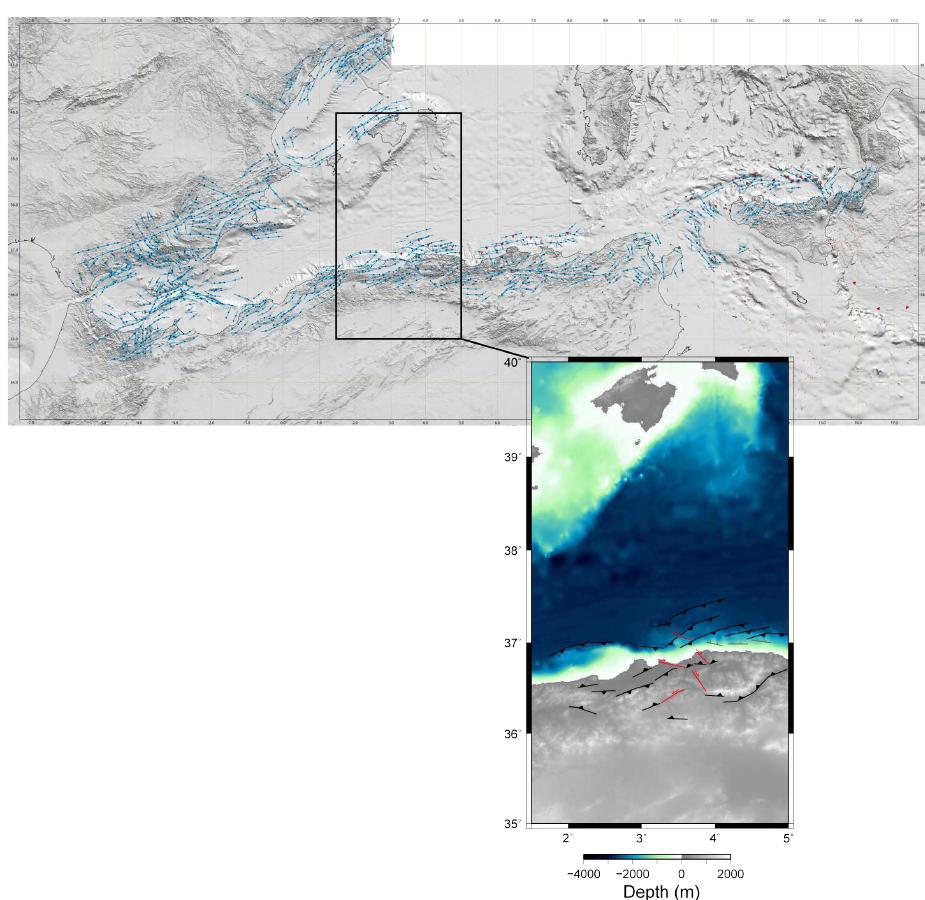
Fig. 2. Simplified fault base used to create segments of 25 km length representing the top edge of each 25 × 20km unit source function stored in the precomputed database (detailed view on the Boumerdès area): (black) thrust faults; (grey) normal faults; (red) strike-slip faults.